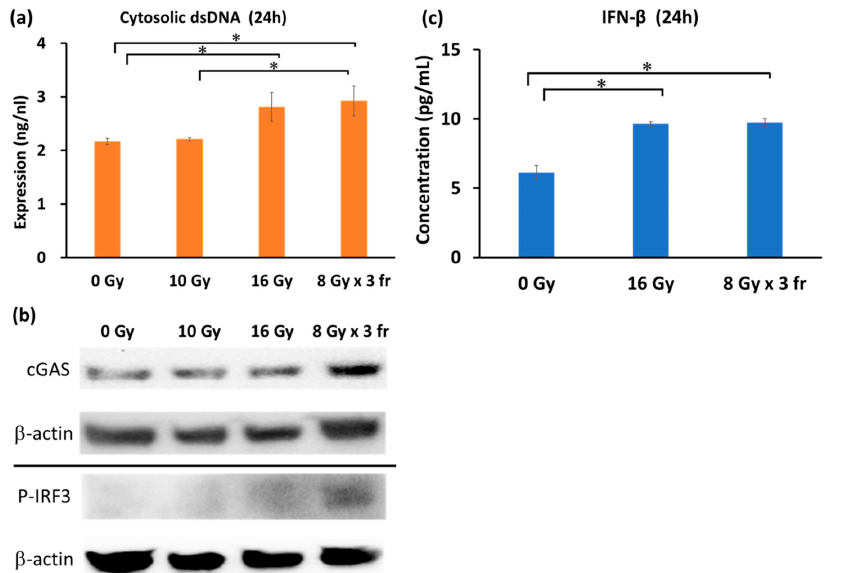
Figure 3. Analysis of the type-I interferon pathway after irradiation. ( a ) The cytosolic dsDNA concentration 24 h after the final irradiation. Tukey–Kramer’s HSD test was performed to compare the difference between 0 Gy (N = 7), 10 Gy (N = 7), 16 Gy (N = 8), and 8 Gy × 3 fr (N = 8). ( b ) The expression levels of proteins in the type-I interferon pathway 24 h after the final irradiation. Untrimmed data are provided in Supplementary Figure S1. ( c ) The IFN- β concentration in cell lysates 24 h after the final irradiation at 0 Gy (N = 3), 16 Gy (N = 4), and 8 Gy × 3 fr (N = 4). Dunnett’s test was performed to compare the difference in the expression level of IFN- β between 0 Gy vs. 16 Gy and 0 Gy vs. 8 Gy × 3 fr. Each error bar represents SE. *: p < 0.05. Abbreviation—fr: fraction. The expression level of cGAS showed the maximum expression level at 8 Gy × 3 fr. The average area density values normalized to a loading control ( β -actin) in three inde- pendent experiments were 0.527 ± 0.168, 0.716 ± 0.207, 0.670 ± 0.181, and 1.283 ± 0.553, at 0 Gy, 10 Gy, 16 Gy, and 8 Gy × 3 fr, respectively. The expression level of phosphorylated- IRF3 (p-IRF3), which plays an important role in the intracellular signal transduction cas- cade, increased in a dose-dependent manner, but only a slight difference was observed between the IFN- β concentration in the cell lysates 24 h after the last irradiation increased at 16 Gy and 8 Gy × 3 fr compared with 0 Gy (Figure 3c). 3.4. Radiation Strongly Inhibited PDAC Growth in Irradiated Tumors but Not in Abscopal Tu- mors The danger signal and type-I IFN pathway were induced by high dose photon irra- diation both in a hypofractionation and in a single fraction; therefore, we next examined whether radiation inhibits tumor growth at the local and abscopal sites using the bilateral tumor-bearing mouse model (Figure 4a,b). Photon beams were irradiated to the tumors on one leg while the rest of the body was shielded by enough thickness of lead blocks when the longest diameter of the tumors reached ≥ 8 mm.